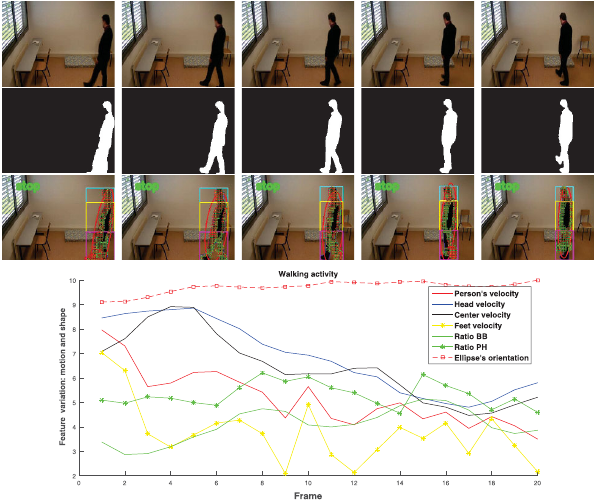
Fig. 13 Walking activity. Row 1: input frames. Row 2: extracted human silhouettes. Row 3: three blocks representation. Graph: variation in feature values over 20 frames.